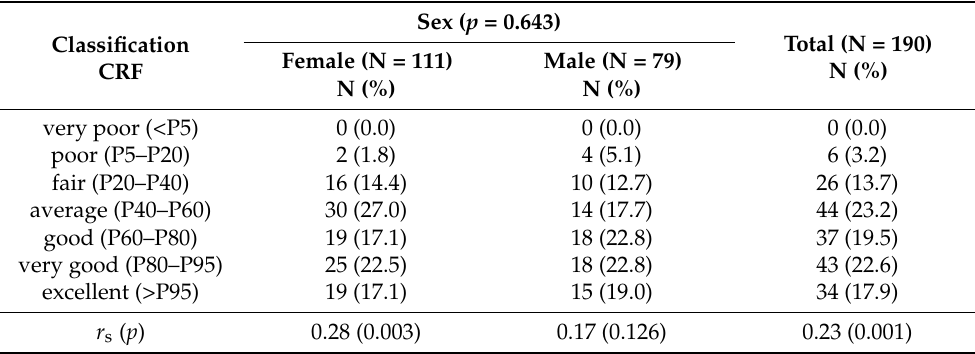
Table 3. Classification of cardiorespiratory fitness with regard to age and sex of the school children as well as to centile